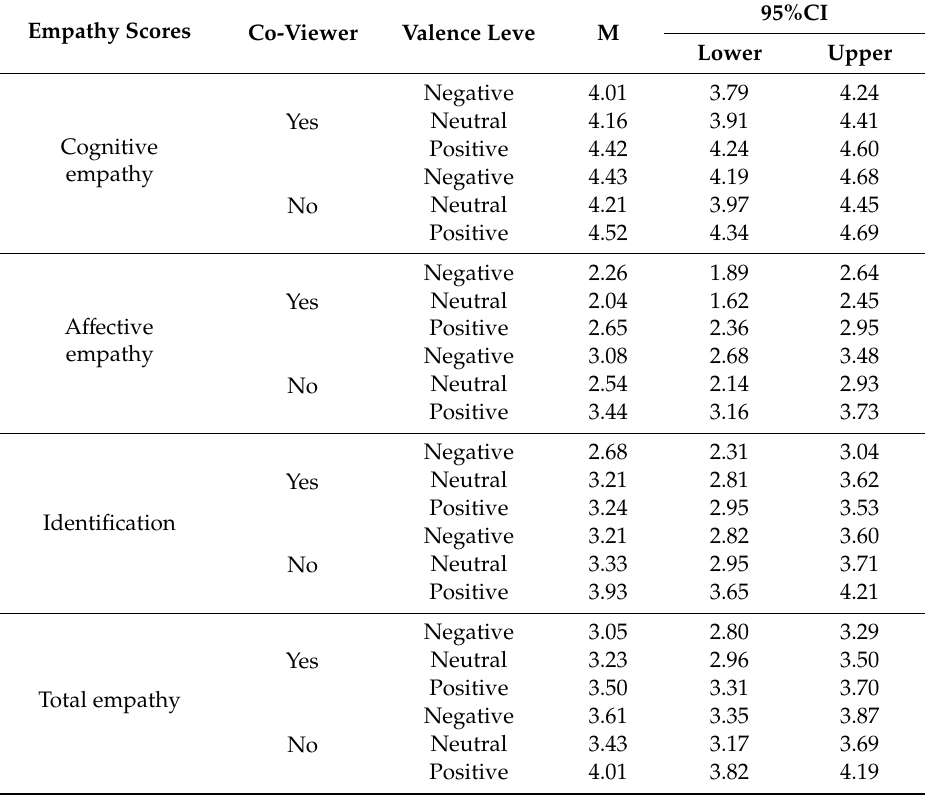
Table 12. Descriptive statistics: Self-reporting empathy scores depending on existence of